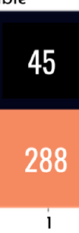
Figure 16. Confusion matrix with final ensemble result.